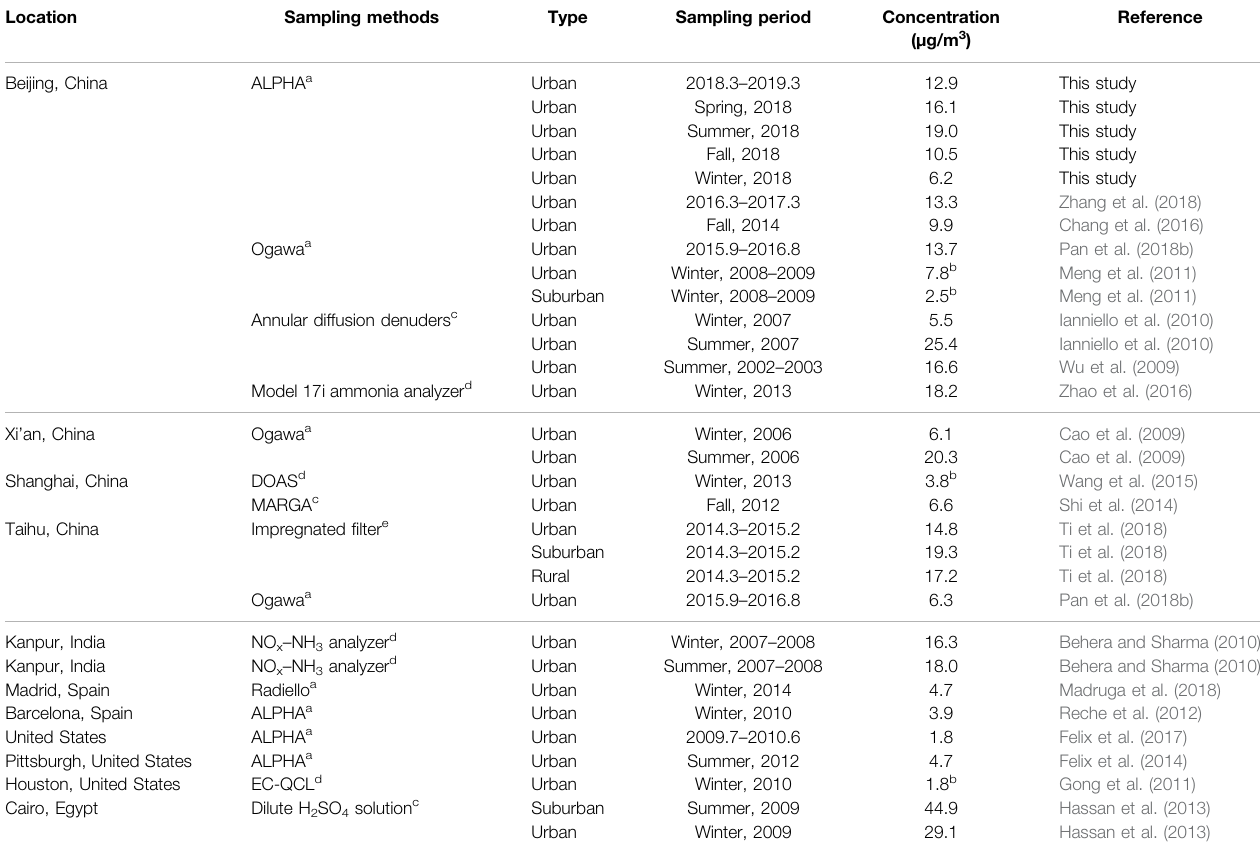
TABLE 2 | Comparison of concentration and δ 15 N values of ambient NH 3